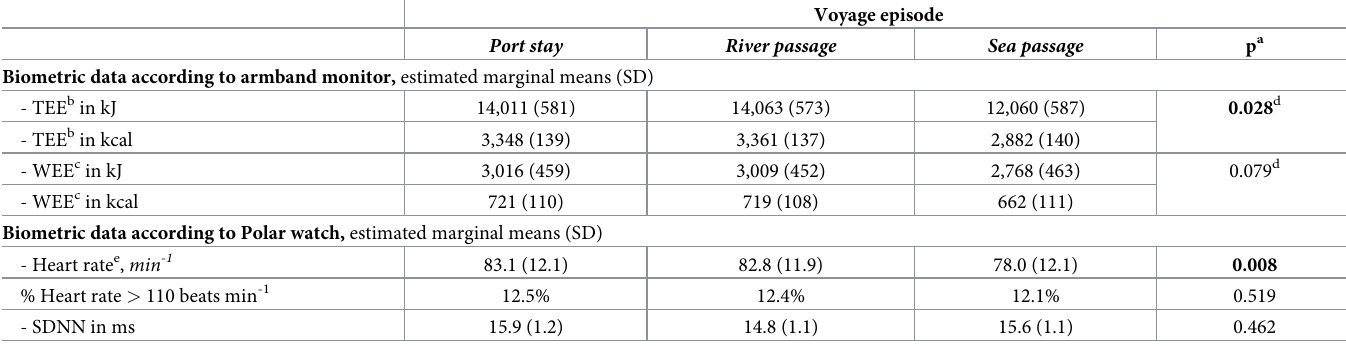
a Mixed Model: p-value calculation for interaction of voyage episode and rank b TEE (Total energy expenditure): total energy expenditure per day c WEE (Work-related energy expenditure): energy expenditure based on a four-hour working time d adjusted for age and body mass index